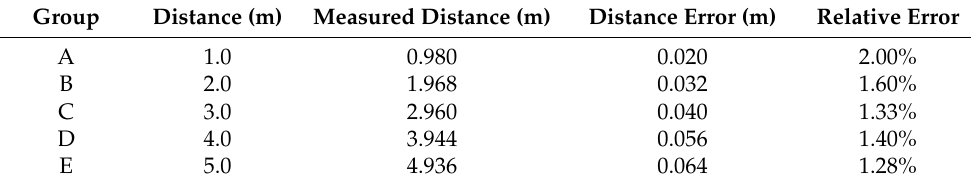
Table 4. Actual scene distance test result.